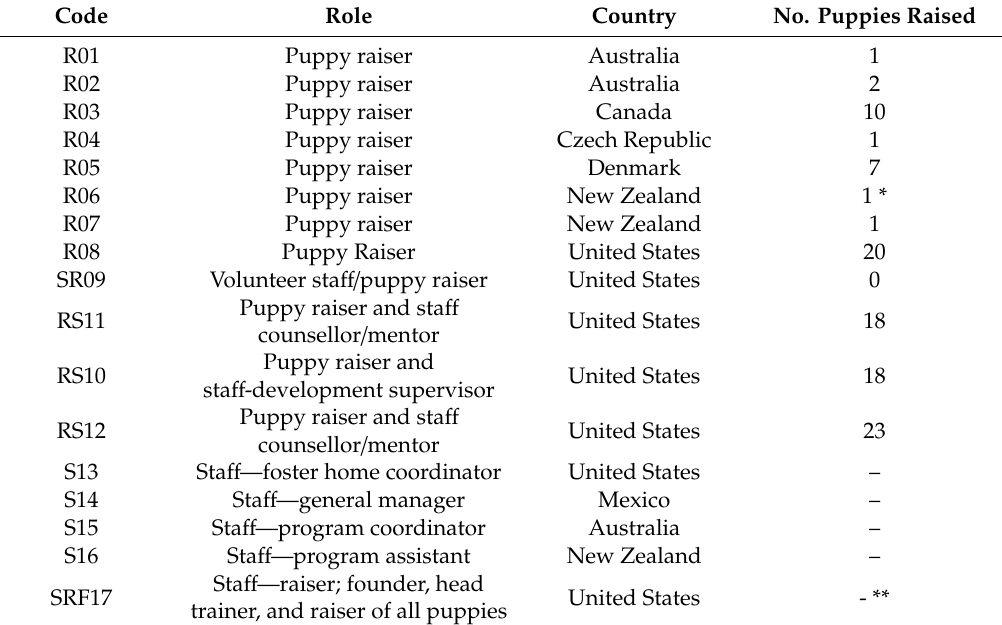
Table 1. Participants’ roles and their